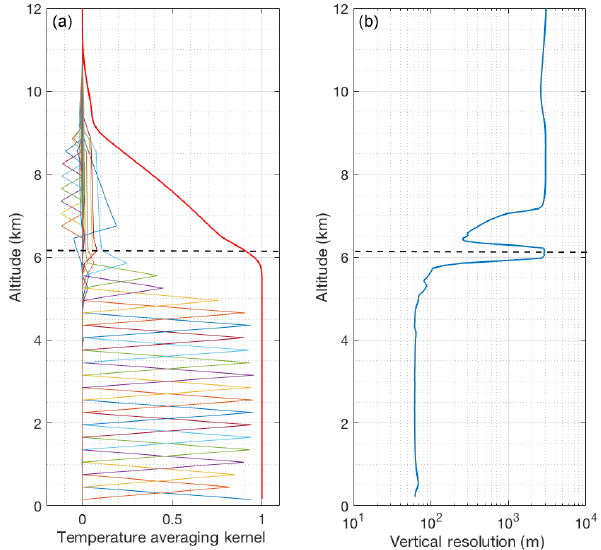
Figure 19. Same as Fig. 3 but for 21 June 2011 with the presence of lower level cloud.